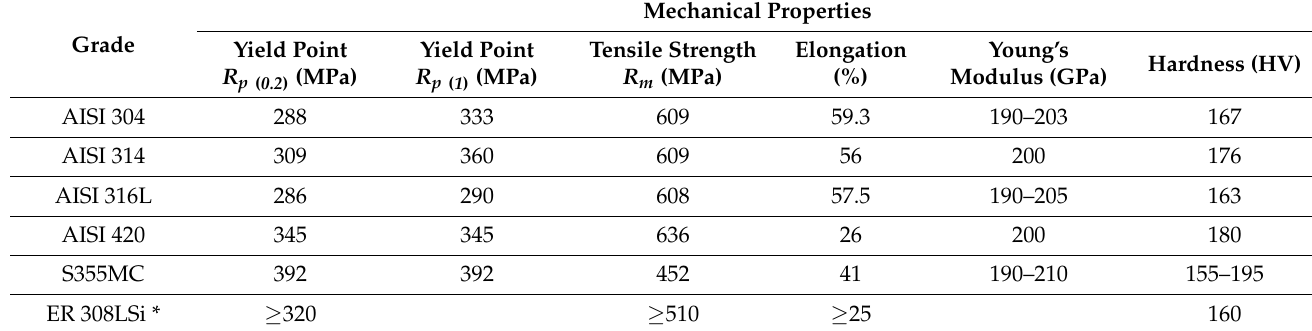
Table 2. Mechanical properties of